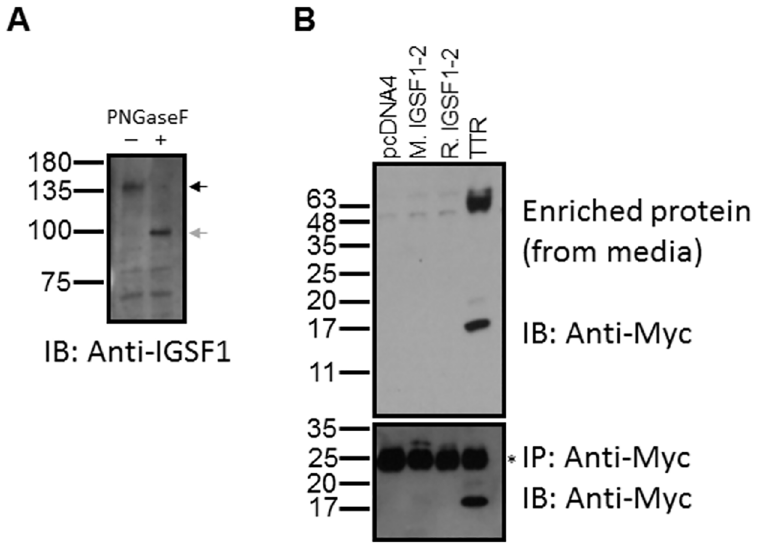
Fig 4. IGSF1-2 is not secreted from homologous HepG2 cells. A) Expression of endogenous IGSF1-CTD in HepG2 cells as determinedby immunoblot using an antibody that recognizes the N-terminus of the CTD (black arrow). Protein lysates were treated with PNGaseF to confirm the specificity of the signal (gray arrow). B) HepG2 cells were transfected with expressionplasmidsfor wild-type murine(M.) or rat (R.) IGSF1-2, murinetransthyretin (TTR), or empty vector (pcDNA4). In all cases, proteins were expressed with Myc/His tags at their C-termini. Media was collectedand His-taggedproteinspurifiedby Ni-NTA chromatography before analysisby SDS-PAGE and immunoblotting for Myc (top). Cell protein lysates were collectedand immunoprecipitated(IP) with Myc-beadsbefore analysisby Myc immunoblot (bottom). Note that the non- specific band( * ) partially obscuresthe rat IGSF1-2 in the bottom panel (third lane).